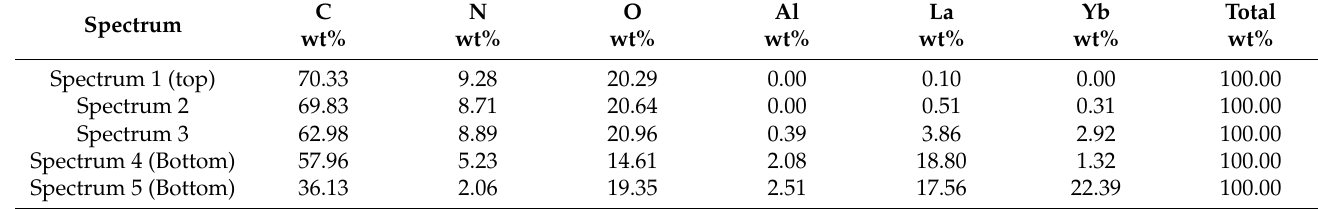
Table 2. EDS elemental analysis of the PEI/LYA(2%) membrane’s cross ‐ section.